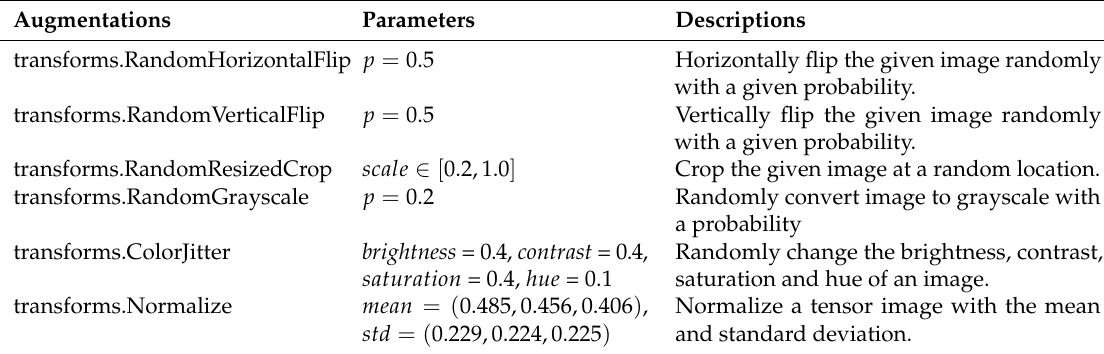
Table 1. Augmentation methods used in this